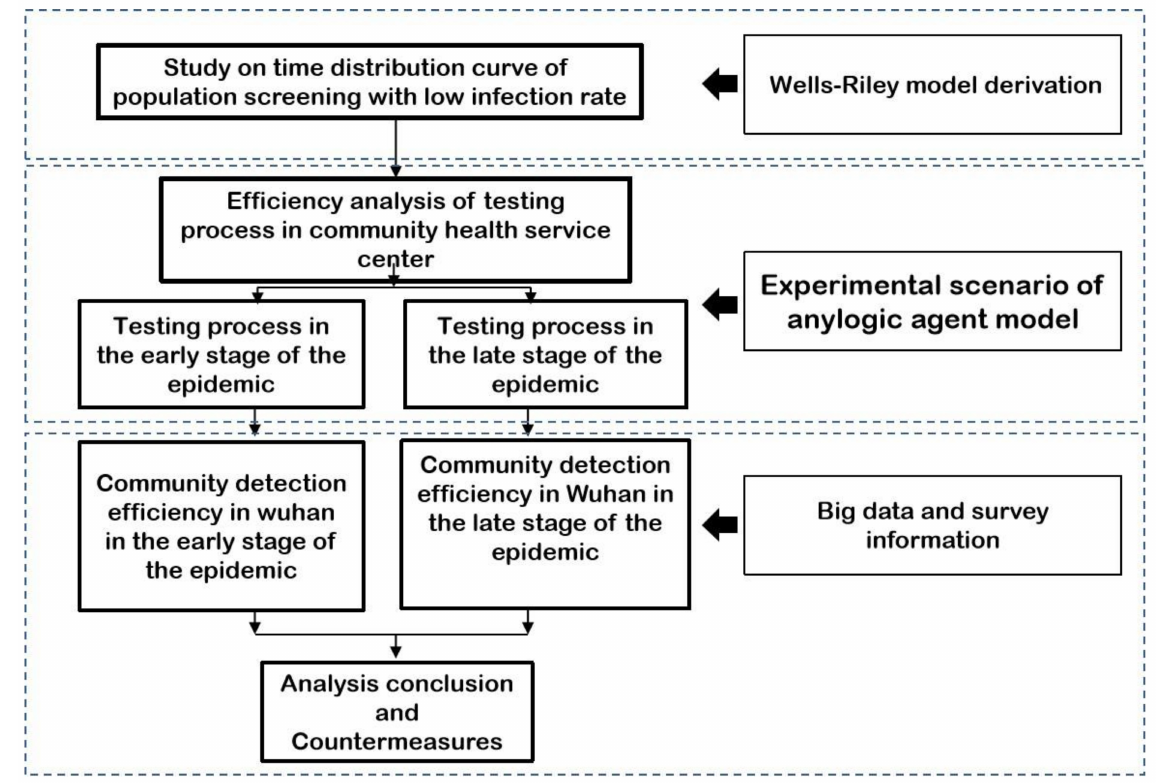
Figure 1. The technical route to construct and analyze the virus testing of